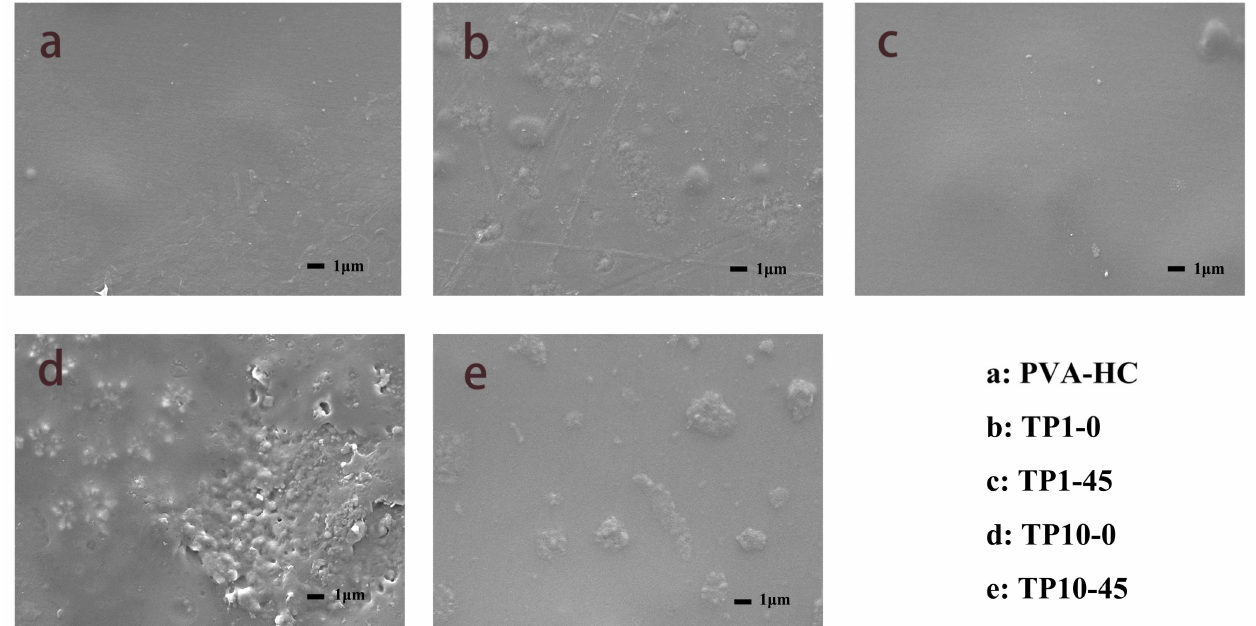
Figure 2. SEM images of PVA-HC and different mass ratios of PVA-HC/TP under different ultrasonic